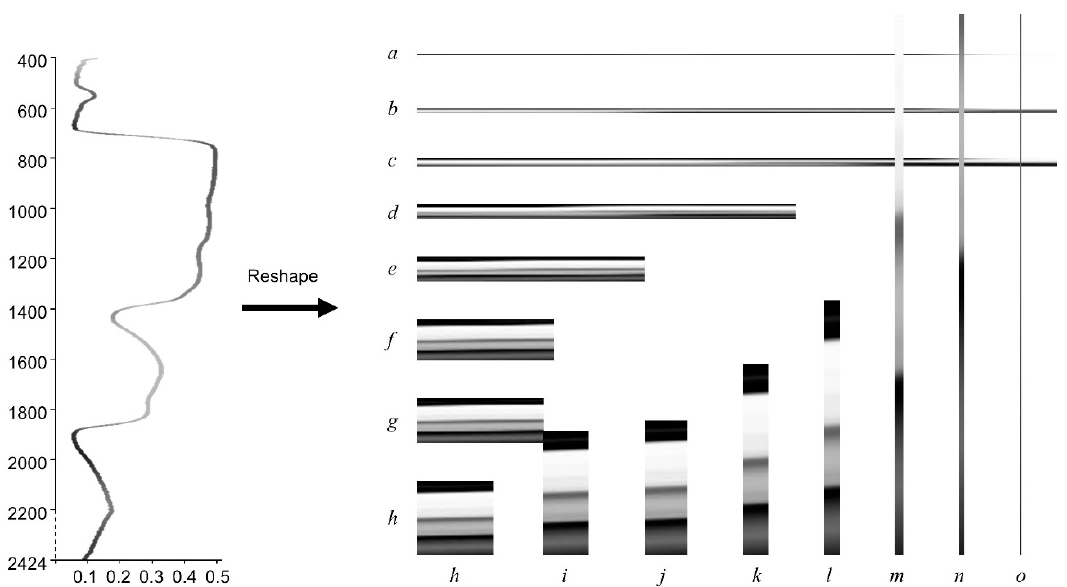
Figure 10. Sample of a reshaped full wavelength reflectance structure data item. Reflectance wave- lengths range from 400 to 2424 nm, and 2025 features are selected. There are 15 factors of 2025 (1, 3, 5, 9, 15, 25, 27, 45, 75, 81, 135, 225, 405, 675, 2025), so the image shape will be: (a) 1 × 2025; (b) 3 × 675; (c) 5 × 405; (d) 9 × 225; (e) 15 × 135; (f) 25 × 81; (g) 27 × 75; (h) 45 × 45 (Figure 3); (i) 75 × 27; (j) 81 × 25; (k) 135 × 15; (l) 225 × 9; (m) 405 × 5; (n) 675 × 3; (o) 2025 × 1 pixels. Each image shape will generate a new dataset to feed the CNN models. Image shapes of (a, b, c, m, n, and o) are not fully demon- strated, as they are either too wide or too tall.